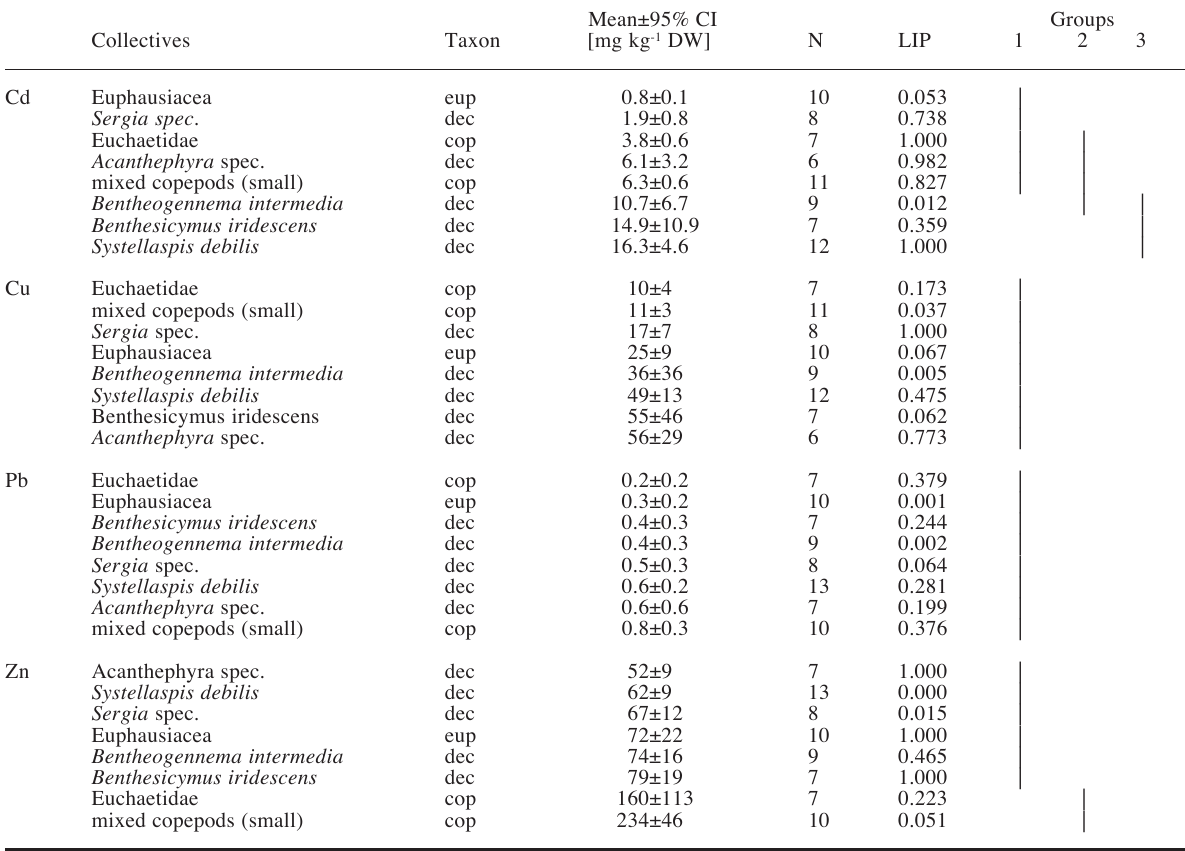
T ABLE 2. – Trace metal concentrations in crustaceans from the Iberian Deep Sea Plain. Acanthephyra: A. pelagica/ A. acanthithelsonis summarised data; dec = Decapoda; eup = Euphausiacea; cop = Copepoda; N: number of determinations; LIP: Lilliefors probability ( α = 0.01); 95%CI: 95% confidence intervals; Bars ( ⎥ ) indicate homogeneous groups according to the Student-Newman-Keuls Multiple Range Test ( α =